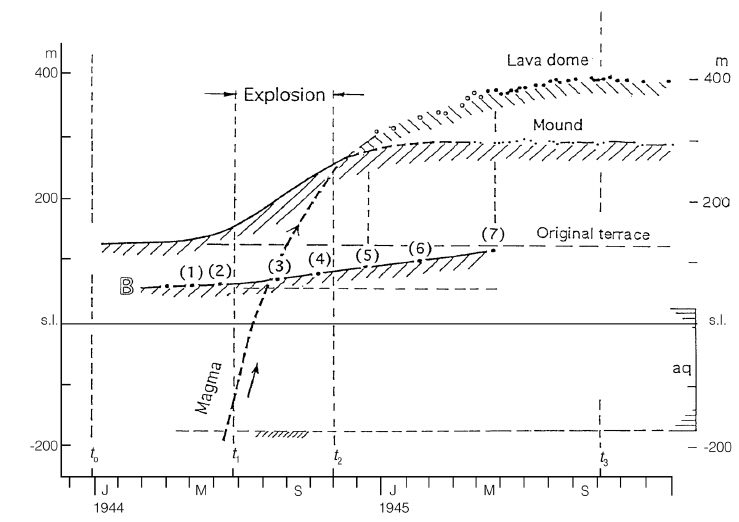
Fig. 7. Magma ascent in the 1943 eruption (thick broken line is assumptive) and growth of lava dome and mound (Yokoyama and Seino, 2000). Hollow circles indicate visual observations and solid ones instrumental de- termination after Fukutomi (1946). Upheaval of point BB, the nearest benchmark to the center of lava dome on leveling route, is shown by a thick line with parenthesized numerals (1 ∼ 7) denoting surveying periods after Mi- nakami et al. (1951); aq, denotes the